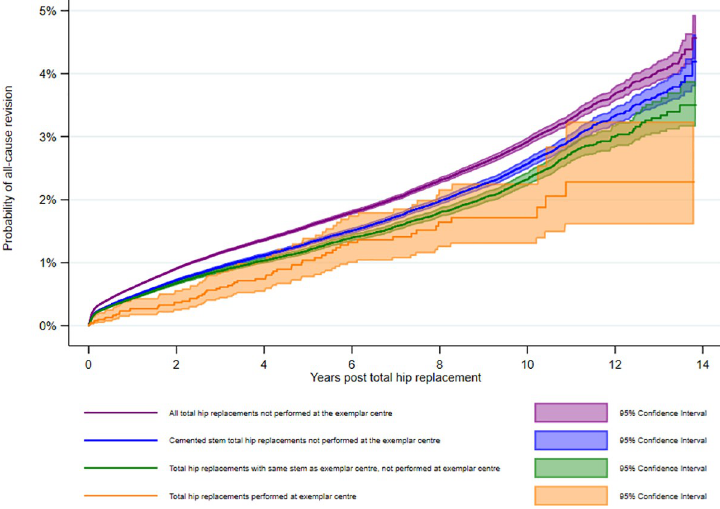
Fig 2. Unadjusted 1-Kaplan–Meier revision estimates of total hip replacements in each subgroup. Comparison of the all-cause construct revision estimates of total hip replacements performed in the exemplar center compared with those performed in all other hospitals in the National Joint